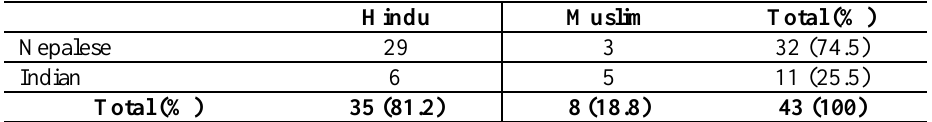
Table III : Nationality & religion of HIV positive patients